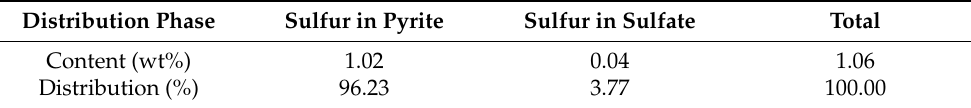
Table 2. Results of iron phase analysis on cyanide tailings.